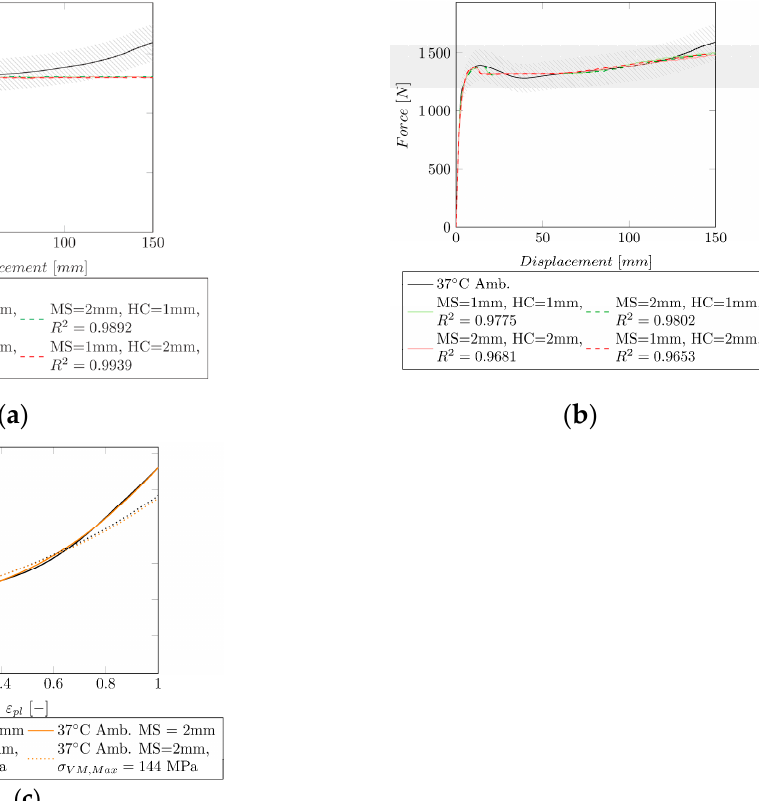
( d ) Figure 6. Comparison of the experimental data to the simulation of Group I for two mesh sizes (MS = 1 mm and MS = 2 mm). HC = 1 mm: HC identified with MS = 1 mm, HC = 2 mm: HC identified with MS = 2 mm. The shaded area indicates a ±10% force region around the experimental curve. ( a ) Experimental and simulated force–displacement curves at 23 °C (ambient) including the resulting